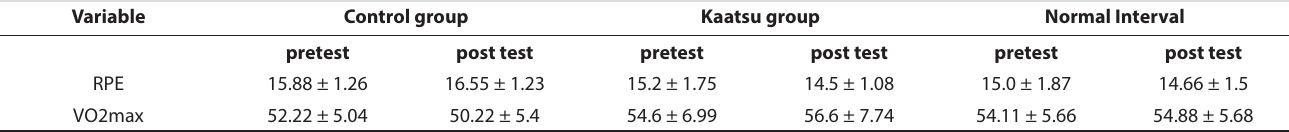
TABLE 2 Deceptive Data for Pre to Post Tests